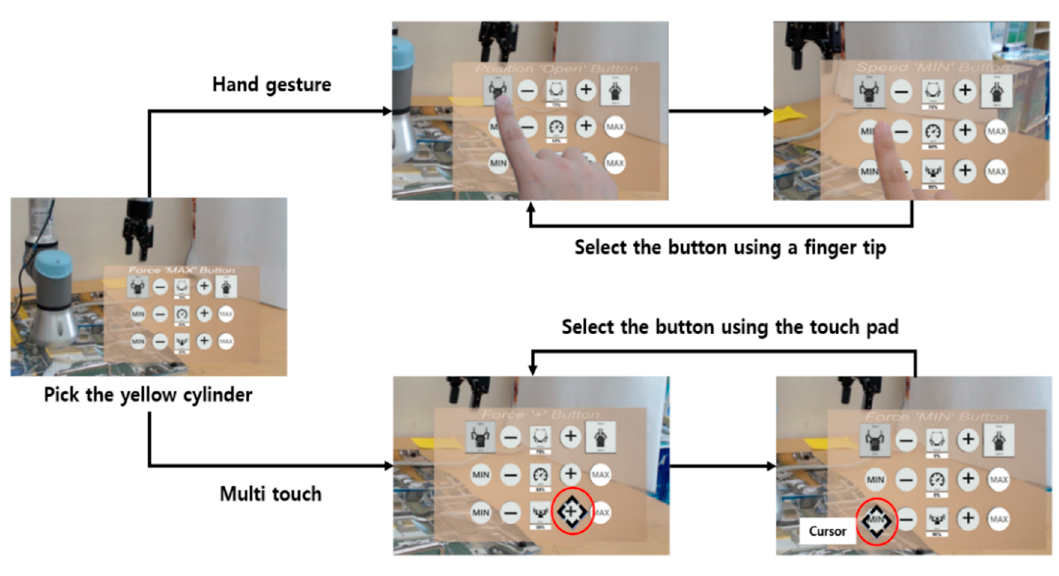
Figure 12. Selection task to operate the UR3 robot.